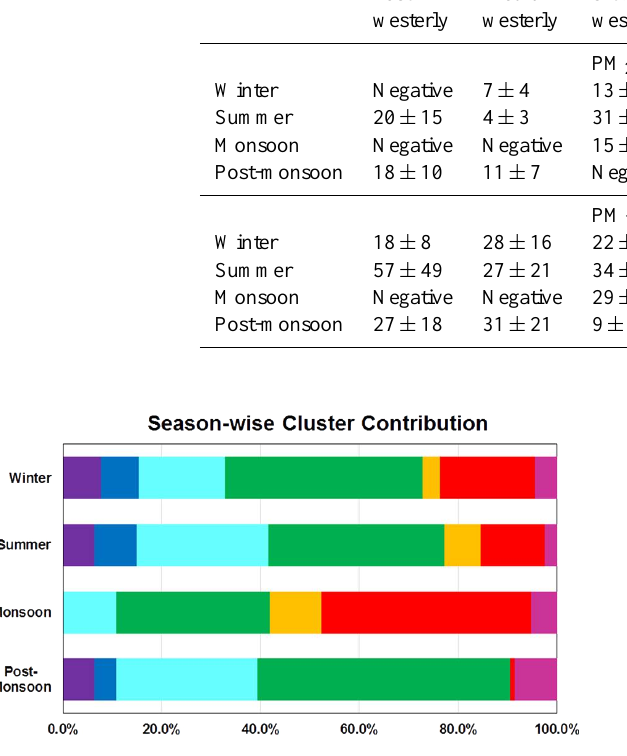
Figure 5. Contribution of individual clusters to air-mass flow for all four seasons. Magenta: calm; red: south-easterly cluster; orange: south-westerly cluster; green: local cluster; light blue: slow westerly cluster; dark blue: medium westerly cluster; purple: fast westerly